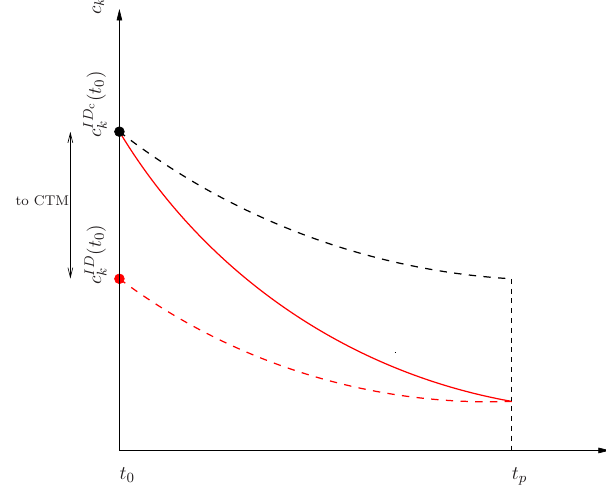
Fig. 8. Sketch of the effective emission indices (EEI) model (Petry et al., 1998). Dashed black lines: concentration evolution using the ID model with the original EI; red solid lines: concentration evolution using the SP model with the original EI; red dashed lines: concentration evolution using the ID model with the